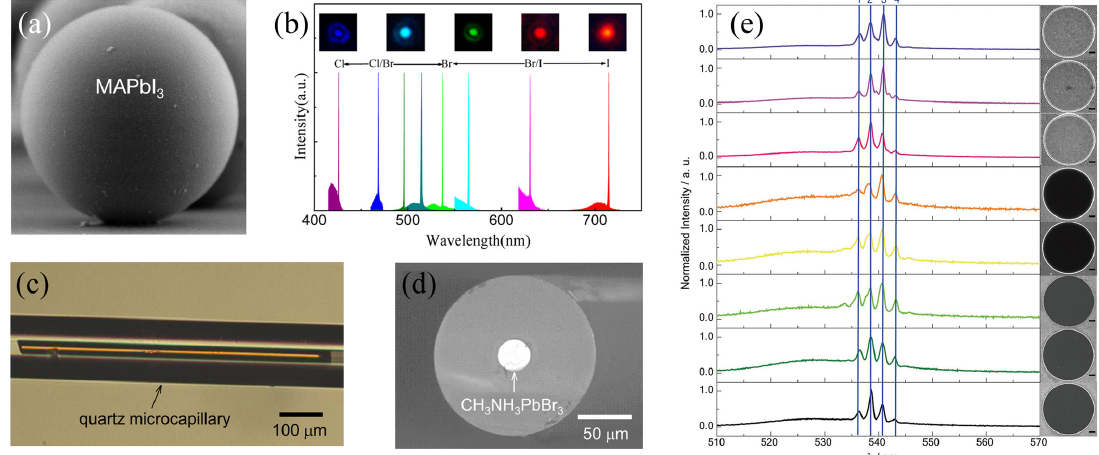
Figure 10. ( a ) SiO 2 microsphere coated with a MAPbI 3 thin film. Adapted with permission from [62]. American Chemical Society, 2014. ( b ) Single mode tunable lasing in CsPbX 3 spheres with different chemical composition. Adapted with permission from [63]. American Chemical Society, 2017. ( c ) Optical micrograph of MAPbBr 3 crystals grown in a SiO 2 microcapillary with internal diameter of 25 µ m. ( d ) Cross sectional SEM image of the same sample. ( c , d ) adapted with permission from [64]. AIP publishing, 2018. ( e ) Lasing spectra of 8 different MAPbBr 3 microdisks realized by